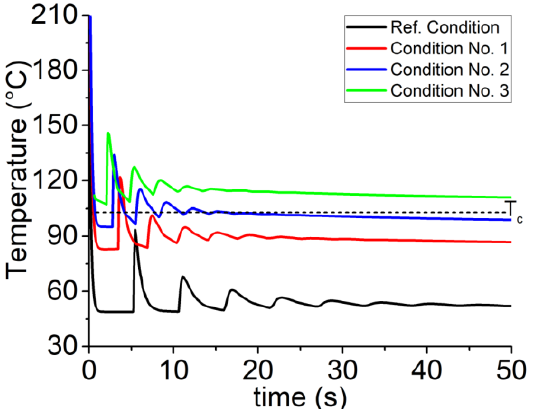
Figure 5. Temperature evolution during the deposition of the first layer of a vertical wall, according to the defined